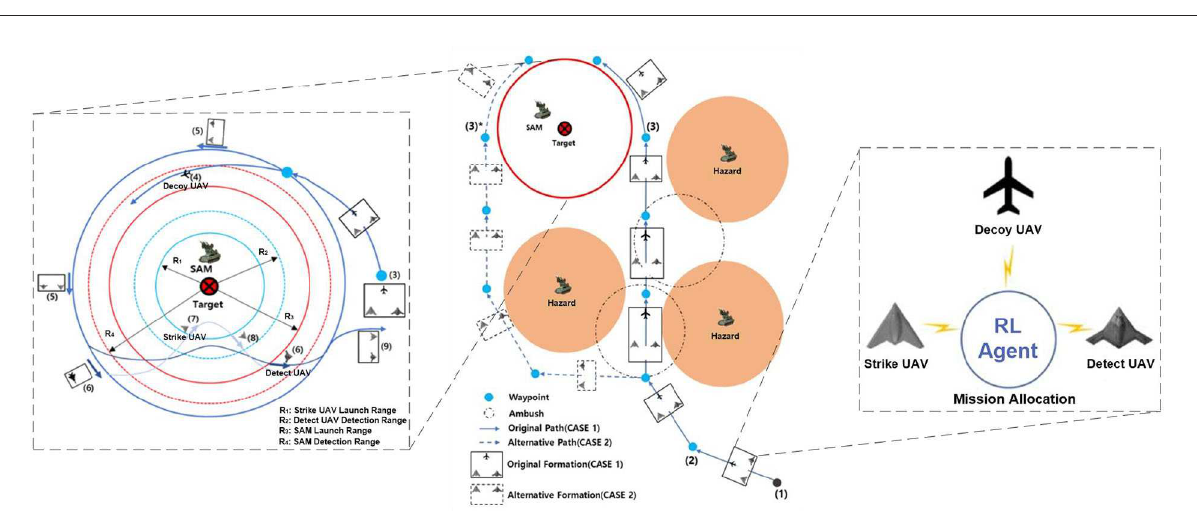
Each UAV is modeled as an RL agent. Figure 2 is a schematic of this mission. As shown in the left side of Figure 2, the detecting and weapon launch ranges of small UAVs (blue-dashed and blue solid circles) are shorter than those of the SAM (red-dashed and red solid circles). Therefore, once the multi-UAV formation reaches the SAM and target airspace, it must implement fine cooperative decisions to complete the strike mission. First, to induce the SAM radar to turn on, the decoy UAV